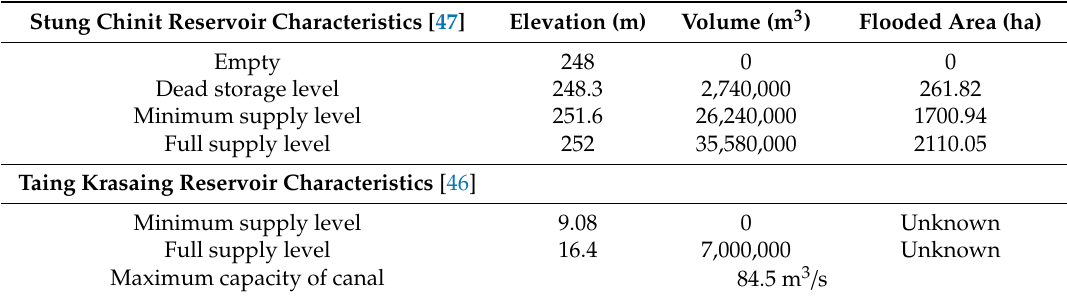
Table 4. Characteristics of the two reservoirs represented in the model.